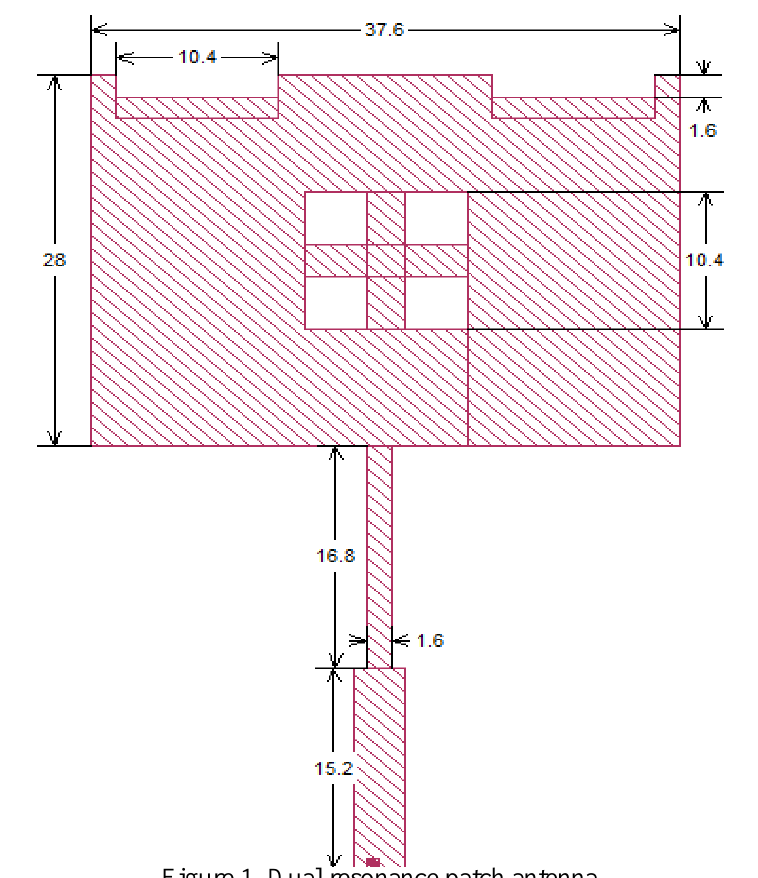
Figure 1. Dual resonance patch antenna